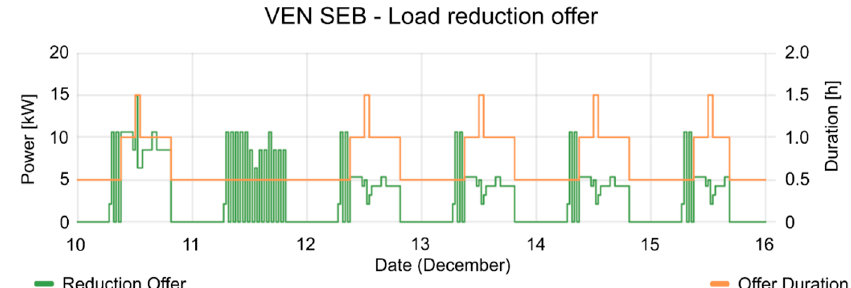
Figure 14. Load Reduction and duration of each offer during the testing period.